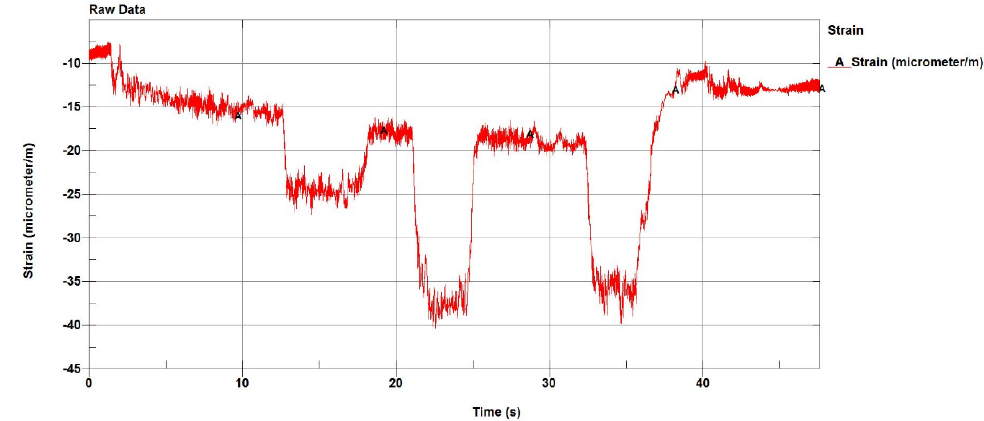
− 60.61 Table 12. Strain induced during hovering, yaw, pitch and roll. Throttle Position Compressive Strain (µm/m) Hovering